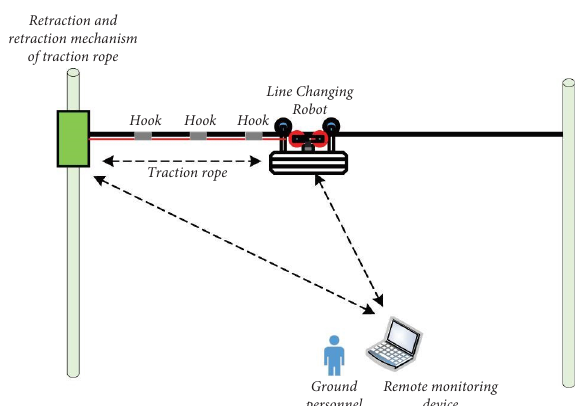
Figure 1: Working scene diagram of the intelligent robot system for disassembly and replacement